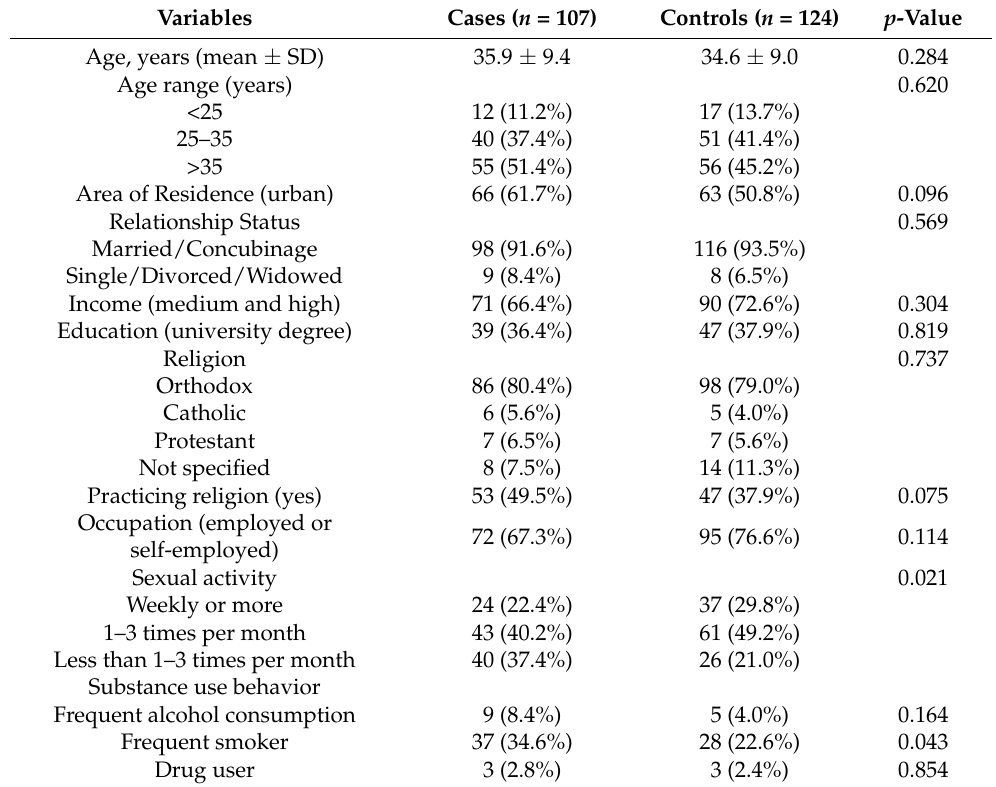
Table 1. Comparison of background characteristics and behaviors between fathers with a disabled child (cases) and fathers with normal children